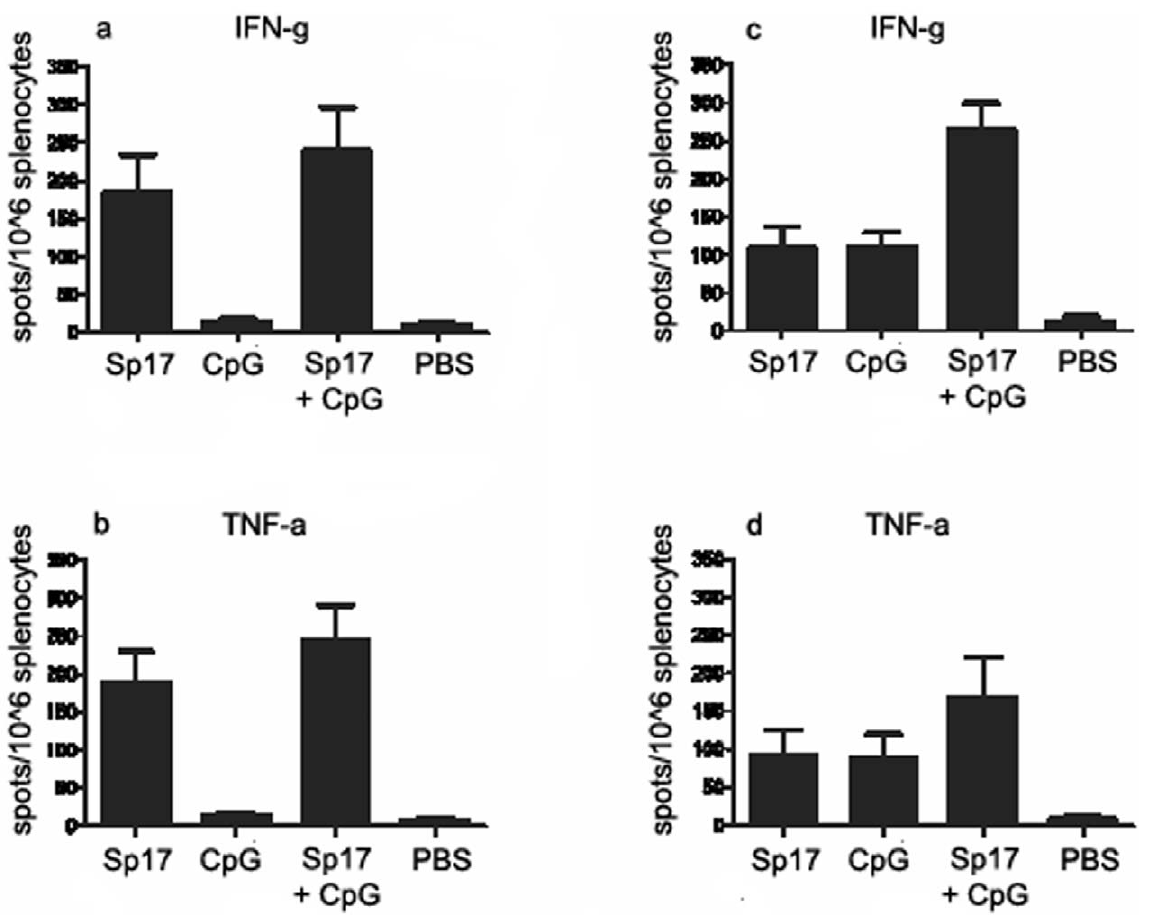
Figure 7. ELISPOT for the assessment of IFN-gamma and TNF-alpha serum levels. On day 270 (9 th vaccine) splenocytes from different formulations of vaccinated mice and controls were collected and analyzed by E.L.I.SPOT assay. a,b ) frequency of IFN-gamma and TNF-alpha positive cells in prophylactic vaccinations; c,d ) frequency of IFN-gamma and TNF-alpha positive cells in therapeutic vaccinations. These results are presented as spot-forming cells per 10 6 splenocytes. Spot numbers represent the mean of ten mice in each vaccinated group; bars, SE.